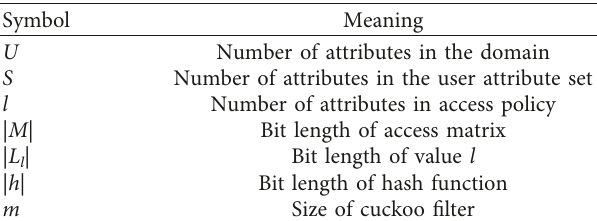
Figure 7: Attribute encryption algorithm model with hidden and verifiable policy. Table 1: Comparison of